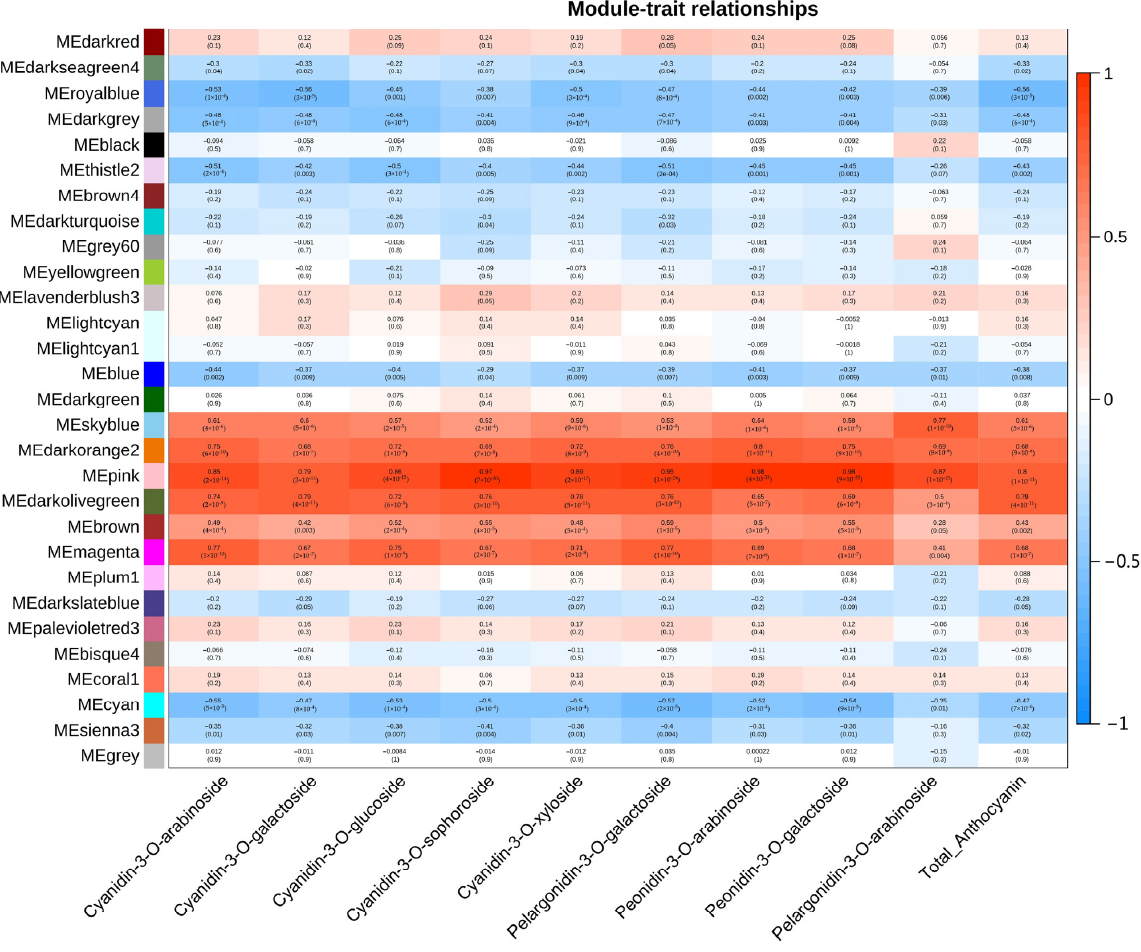
Figure 3. WGCNA analysis of gene expression levels and anthocyanin content. Different module colors represent the correlation between the genes of the module and anthocyanins. The brighter the red (value closer to 1), the higher the positive correlation, while the brighter the blue (value closer to − 1), the higher the negative correlation. The number in brackets represents significance ( p -value); the smaller the value, the stronger the significance. The horizontal axis represents the types of